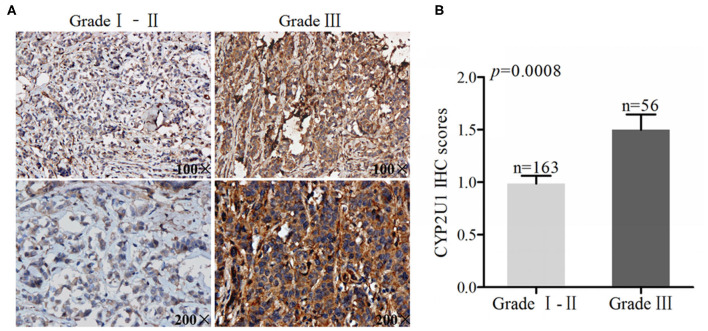
Analyses of cytoplasm CYP2U1 expression in low-grade and high-grade breast tumors. (A) Representative images of CYP2U1 protein abundance in low-grade and high-grade breast tumors are shown. (B) Semi-quantitative result is displayedas the mean ± SEM.